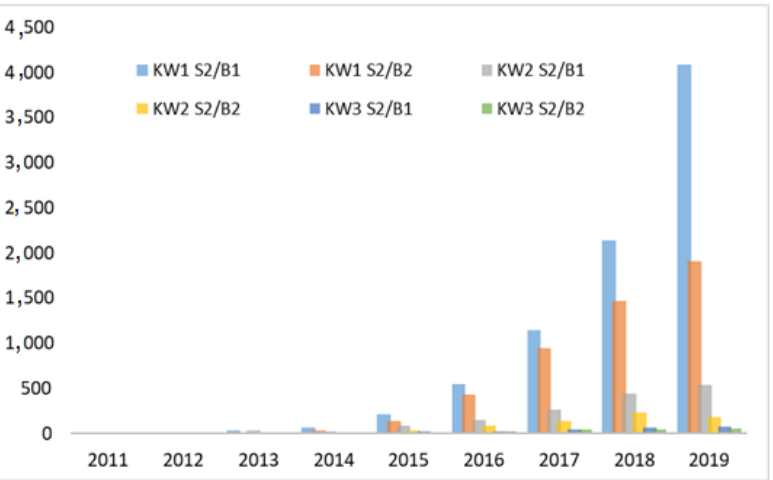
Figure 7. Dynamics of publishing for particular keywords (KW) in the segment S2 “Industry 4.0”. Source: Own study based on the databases: Web of Science and Scopus.